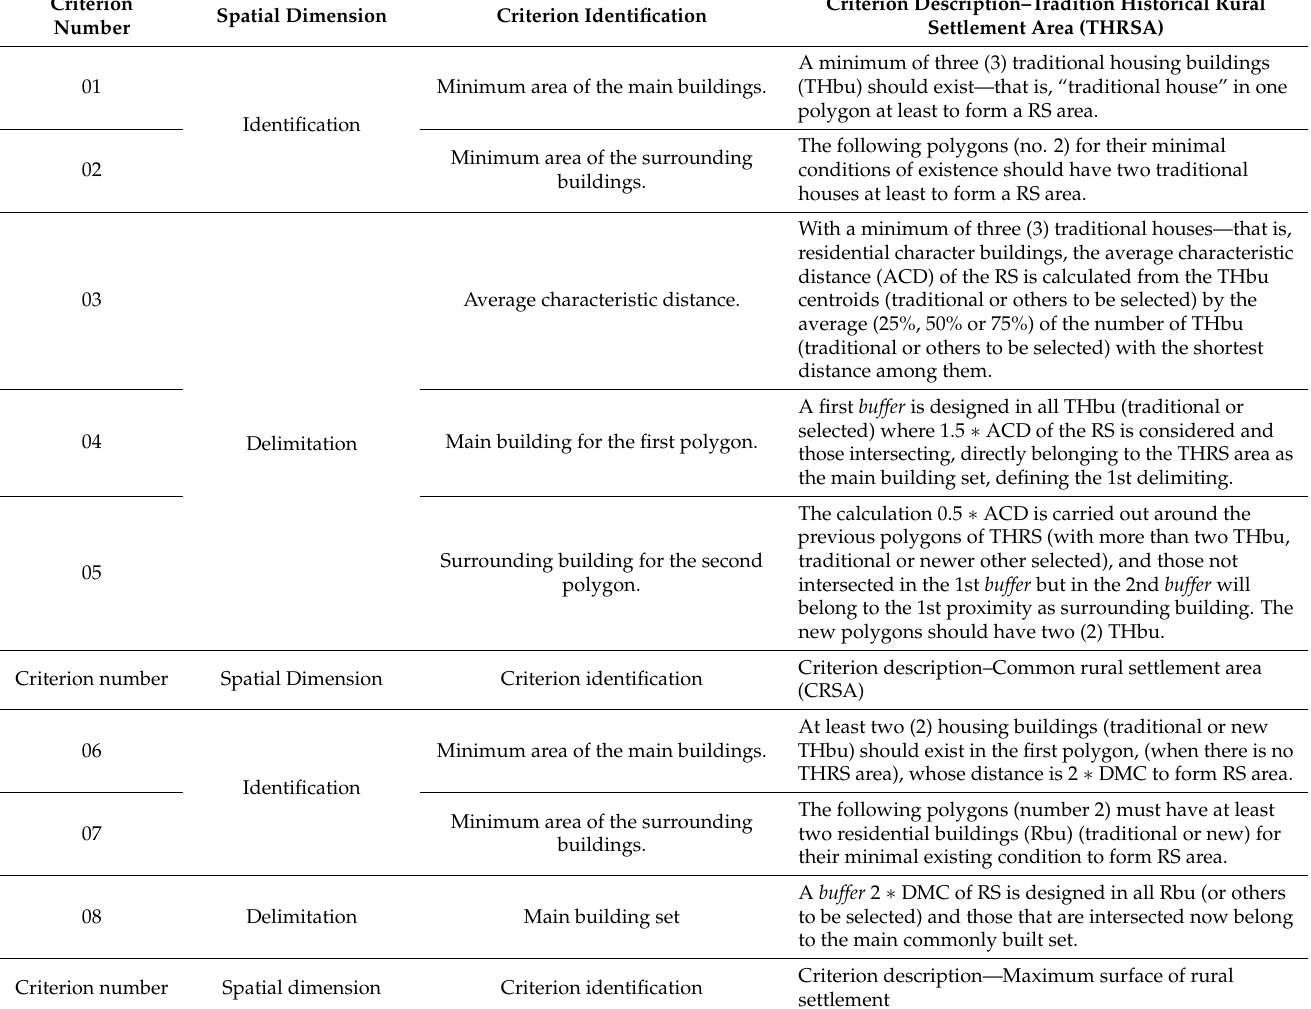
Table 4. Criteria for identification and delimitation of a RS. Source: